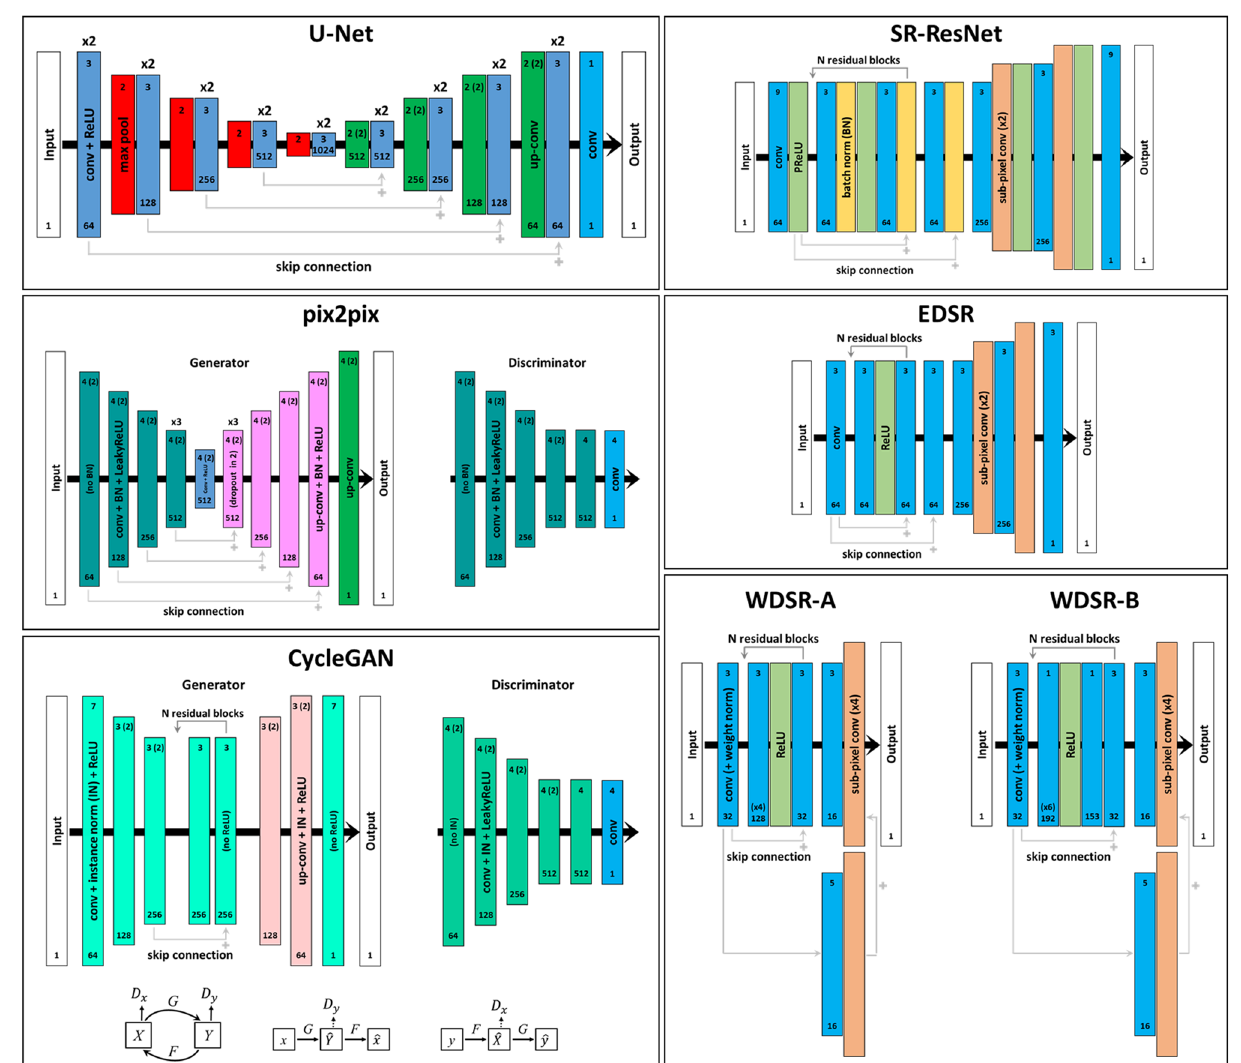
Figure 8. Super-resolution networks. Convolutional neural networks (CNNs: U-Net, SR-ResNet, EDSR, WDSR-a, WDSR-b) and generative adversarial networks (GANs: pix2pix, CycleGAN) employed for super- resolution imaging. Blocks of the same color represent the same type of layer(s); if they are repeated for several times, it is reported above the blocks (e.g., 2×). For (2D or 3D) convolutional layers, the number of filters is provided at the bottom and the kernel size (together with the strides, in the bracket, when different from 1) at the top. Bottom light-gray arrows show skip connections (concatenation for U-Net, pix2pix, CycleGAN, addition for SR-ResNet, EDSR, WDSR-a, WDSR-b), whereas top dark-gray arrows indicate residual blocks for ResNet-based networks (SR-ResNet, EDSR, WDSR-a, WDSR-b) and